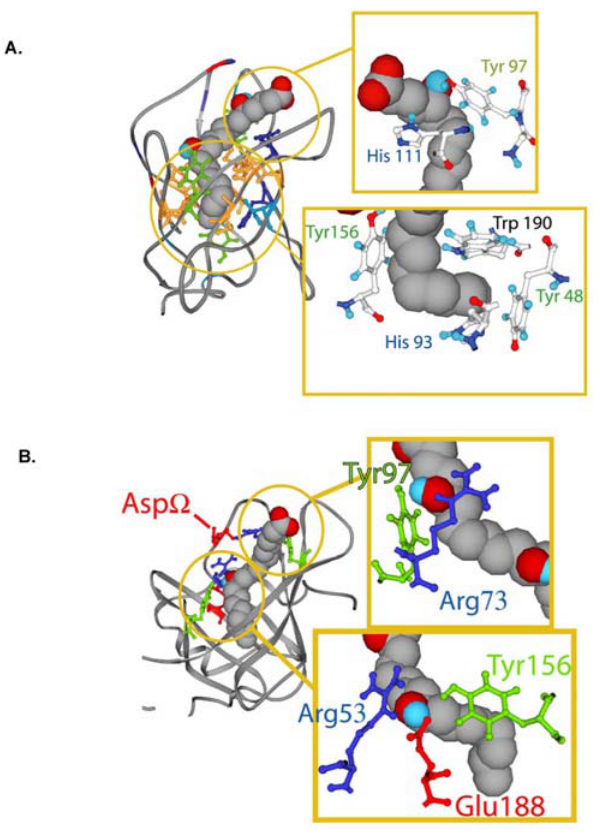
Figure 4. Snapshots of the molecular dynamics simulation of Ir- LBP interacting with LTB4. Ir-LBP is represented by a ribbon and LTB4 in CPK. Tyr are green and positive, negative and hydrophobic residues are blue, red and orange, respectively. A. Zoom on the carboxyl group and the hydrophobic tail of LTB4. B. Zoom on two hydroxyl groups of